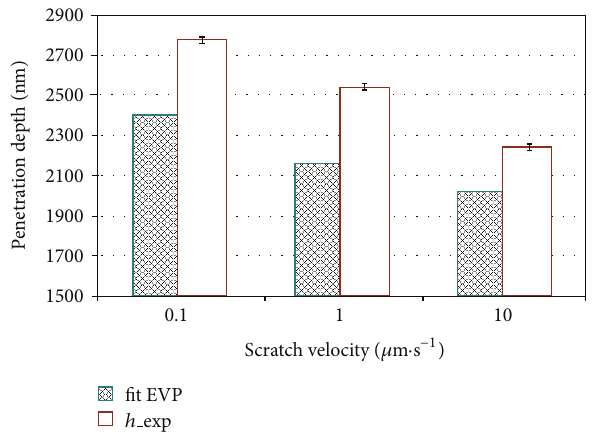
Figure 9: Comparison of experimental results ( ℎ exp) and numer- ical results (fit EVP) for 𝐹 𝑛 = 20 mN. The numerical results have been obtained with the elastic-viscoplastic model in using a Young modulus of 3.75 GPa. The set of parameters have been identified from experimental scratch results at 20mN.